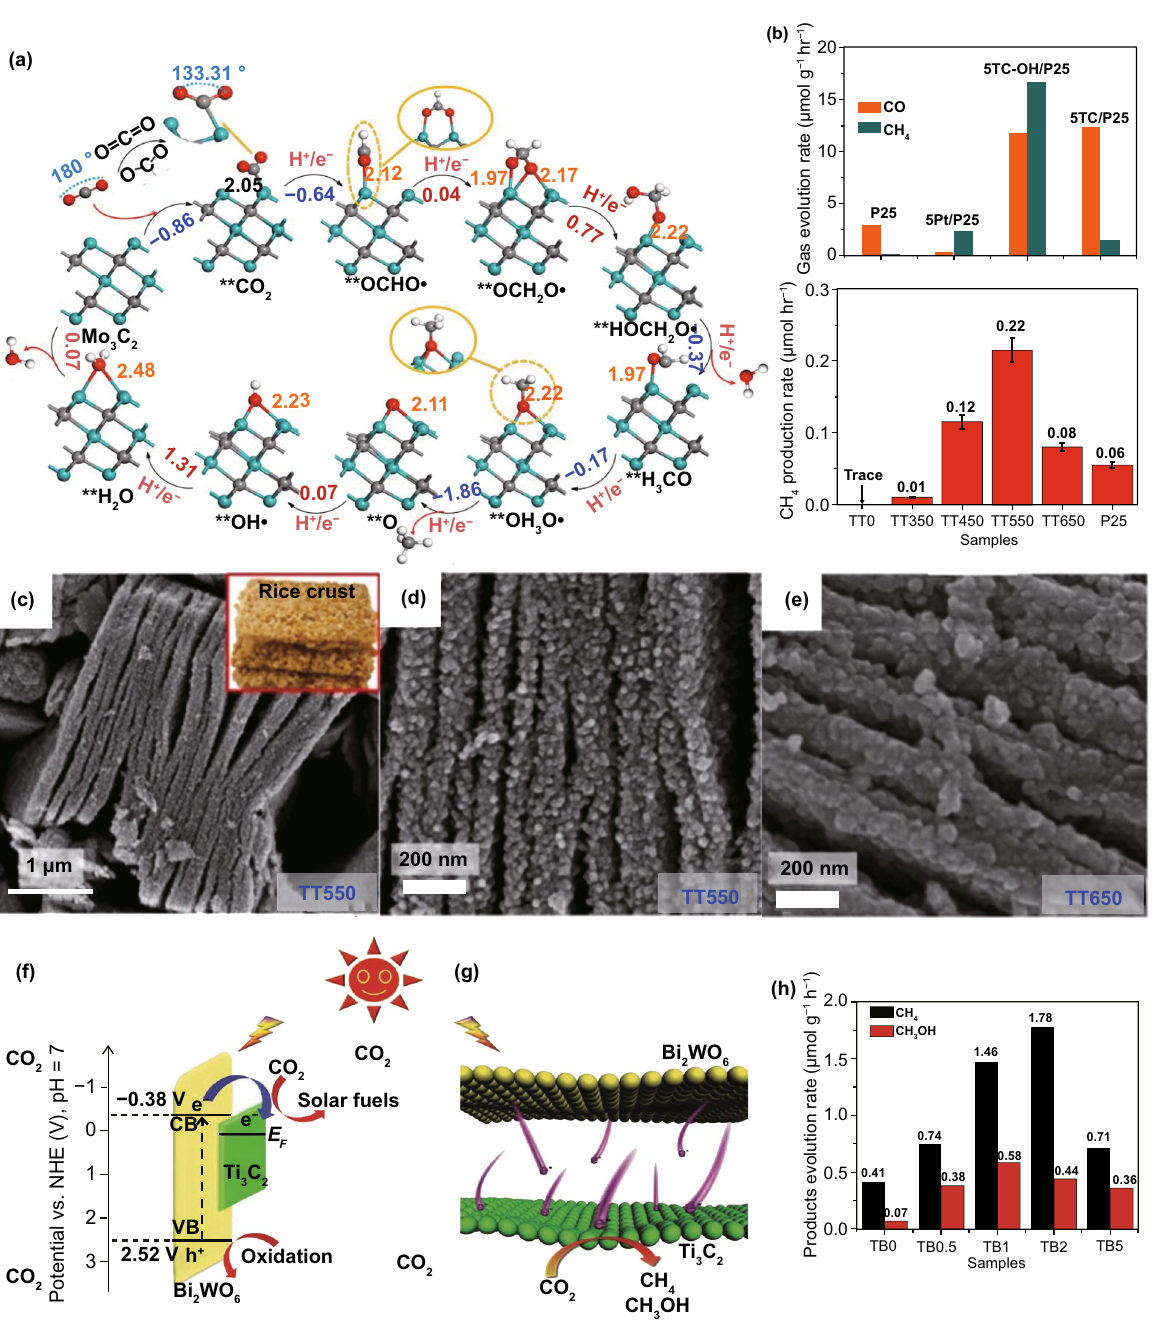
Fig. 20 a Lowest amount energy routes (PBE/DFT‑D3 calculations) pursued for CO 2 into *CH 4 and **H 2 O conversion, catalyzed by Mo 3 C 2 . Gray, lilac, red, and white spheres indicate C, Mo, O, and H atoms, correspondingly (Li et al. [248]). b Photo‑catalytic CO and CH 4 evolution rates over P25, 5Pt/P25, 5TC/P25, and 5TC‑OH/P25 (Ye et al. [249]). C–f Photo‑catalytic CO 2 RR of the TiO 2 /Ti 3 C 2 (TT‑ x ) samples and P25 for the CH 4 formation ( c ) and FE‑SEM images of TT550 ( d , e ) and TT650 ( f ) (Low et al. [250]). g , h Photo‑induced e − migration method at Ti 3 C 2 / Bi 2 WO 6 hetero‑interface ( g ) and photo‑catalytic activity of Ti 3 C 2 /Bi 2 WO 6 through diverse mass ratios of Ti 3 C 2 to Bi 2 WO 6 (0%, 0.5%, 1%, 2%, and 5%) ( h ). Adapted with permission from Ref.